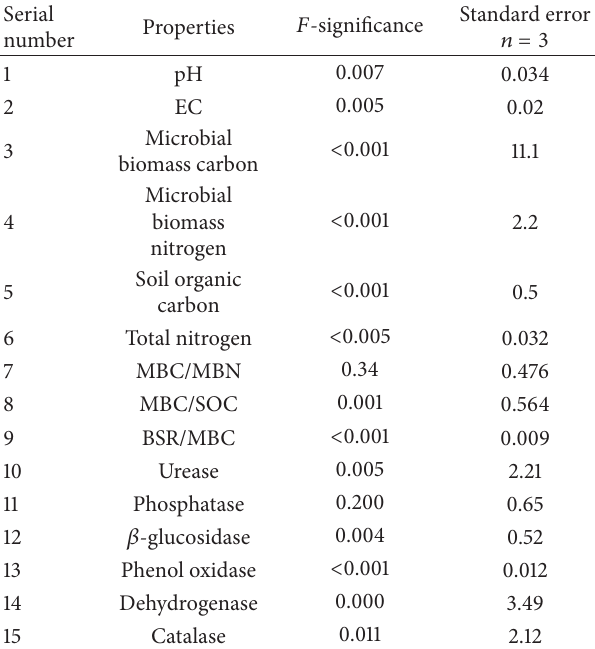
Table 3: PCA analysis of soil microbial parameters under the rhizosphere of different tree species.